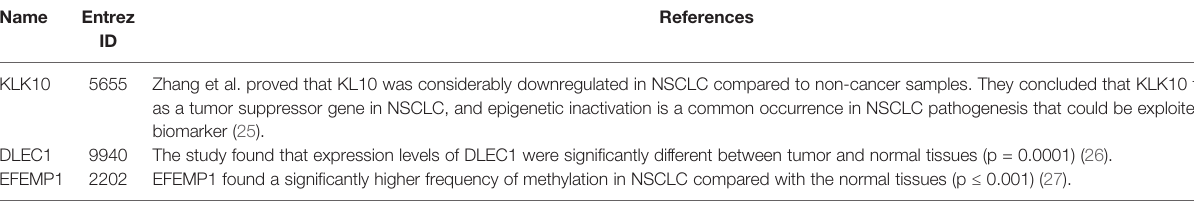
TABLE 4 | The details of genes that we mined by Deep-LC